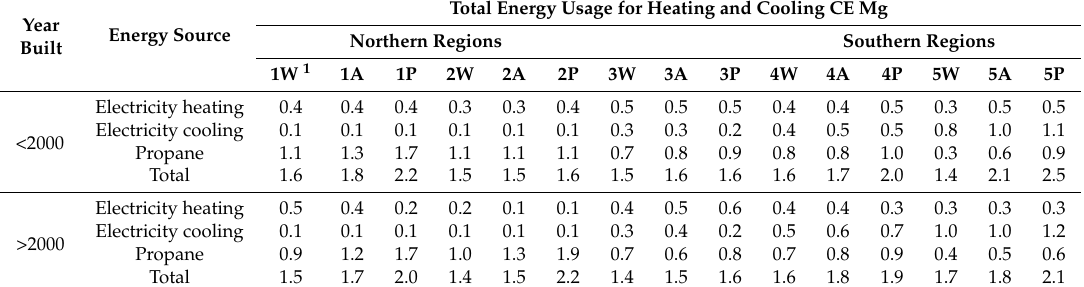
Table 3. Carbon equivalent emissions for heating and cooling rural houses built before and after 2000 using different energy sources and insulation types in different climatic